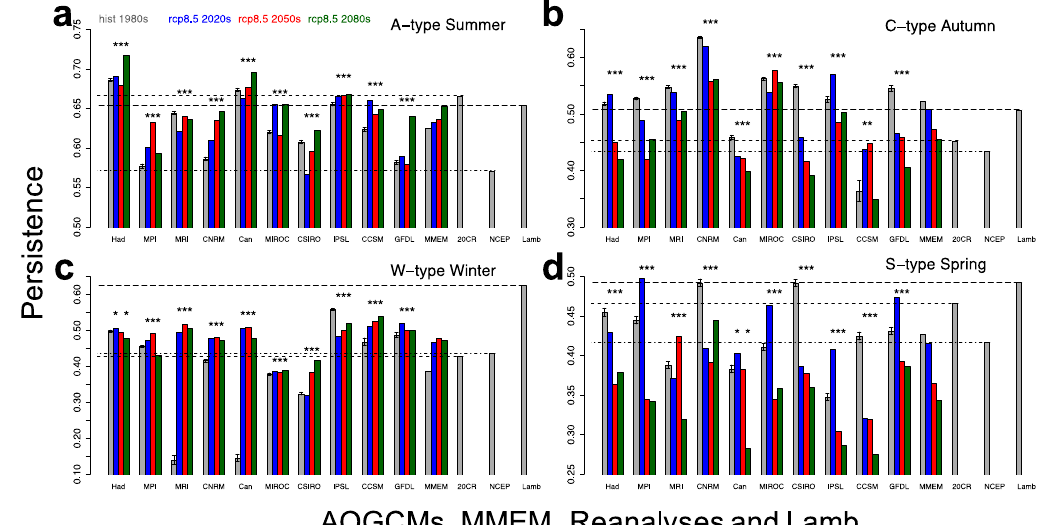
Figure 4. Persistence of selected LWTs and seasons for individual AOGCMs under RCP8.5. ( a ) Anticyclonic (A) type (summer JJA), ( b ) cyclonic (C) type (autumn SON), ( c ) westerly (W) type (winter DJF) and ( d ) southerly (S) type (spring MAM) in the 1980s compared with the 2020s, 2050s and 2080s under RCP8.5. Persistence is shown for individual AOGCMs alongside the multi-model ensemble mean (MMEM), 20CR, NCEP and Lamb’s subjective catalogue. Asterisks (*) show model runs with persistence outside the 95% confidence intervals of the boot-strapped (n = 1000) estimates for the 1980s, shown here as black T-bars. Dashed lines represent the reanalyses and Lamb’s catalogue values.